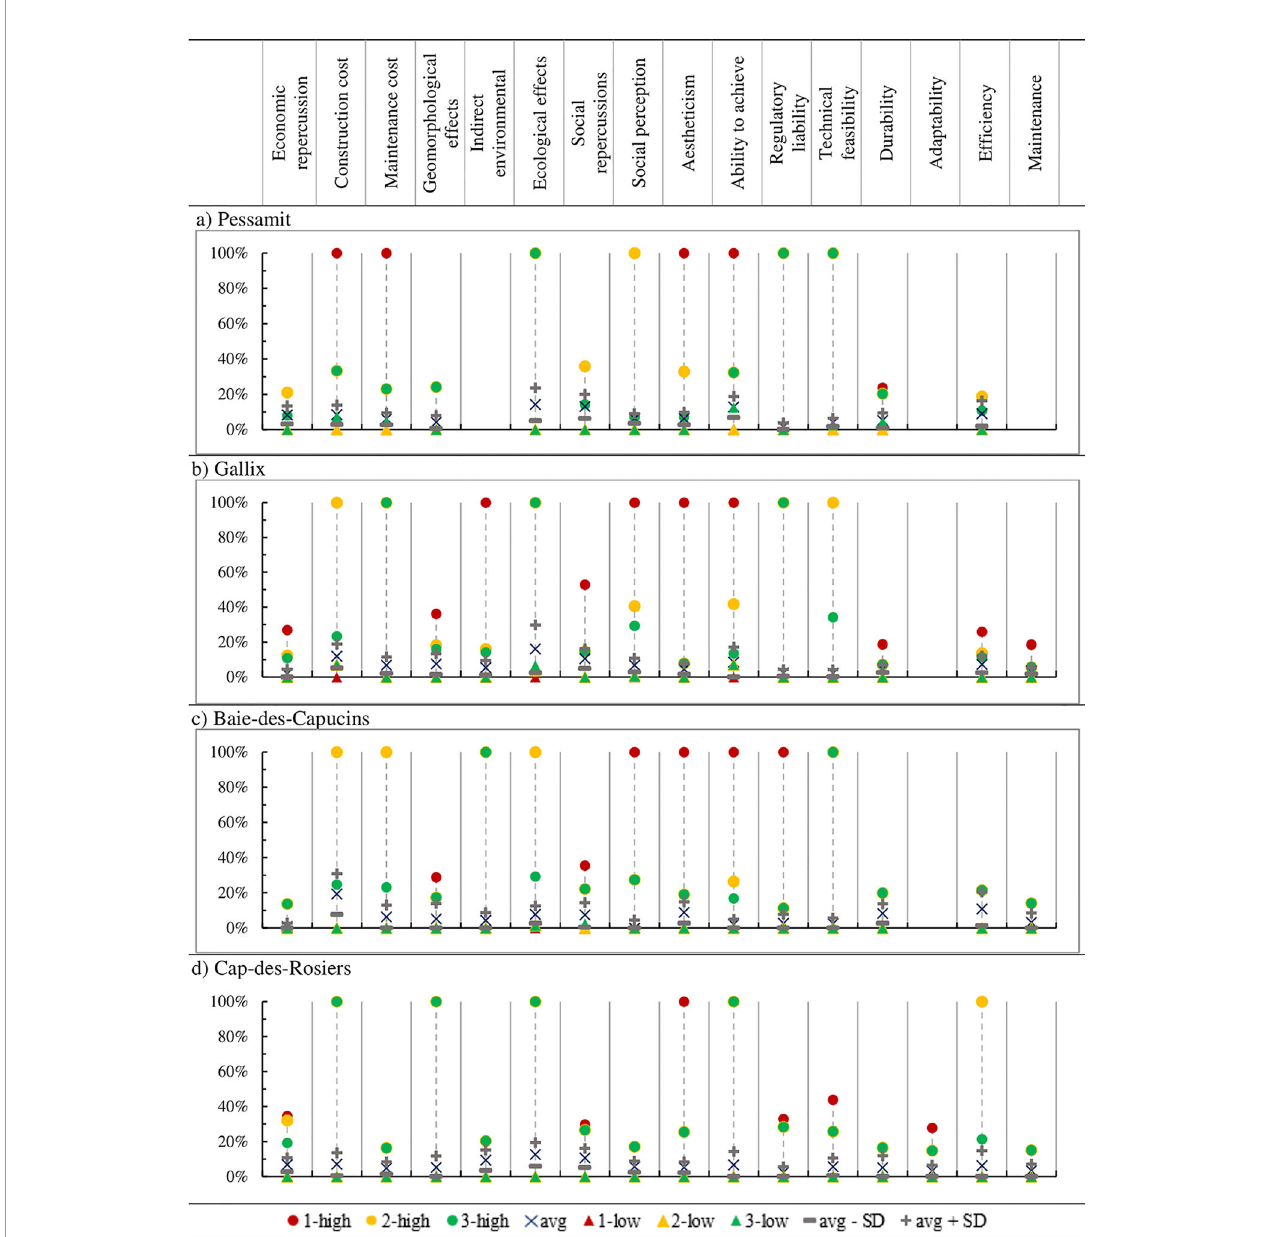
FIGURE 8 | Robustness analysis of CDMs ranked 1 (red), 2 (yellow), and 3 (green), in relation to each criterion for each site (A) Pessamit; (B) Gallix; (C) Baie-des- Capucins; (D) Cap-des-Rosiers). The vertical axis shows the average criteria weight in percentage. The circles and triangles show the highest and lowest thresholds at which there is a change in the top 3 ranked CDMs for a given criterion. The blue X shows the criterion weighted average. The grey plus and minus signs show the weighted average plus and minus the standard